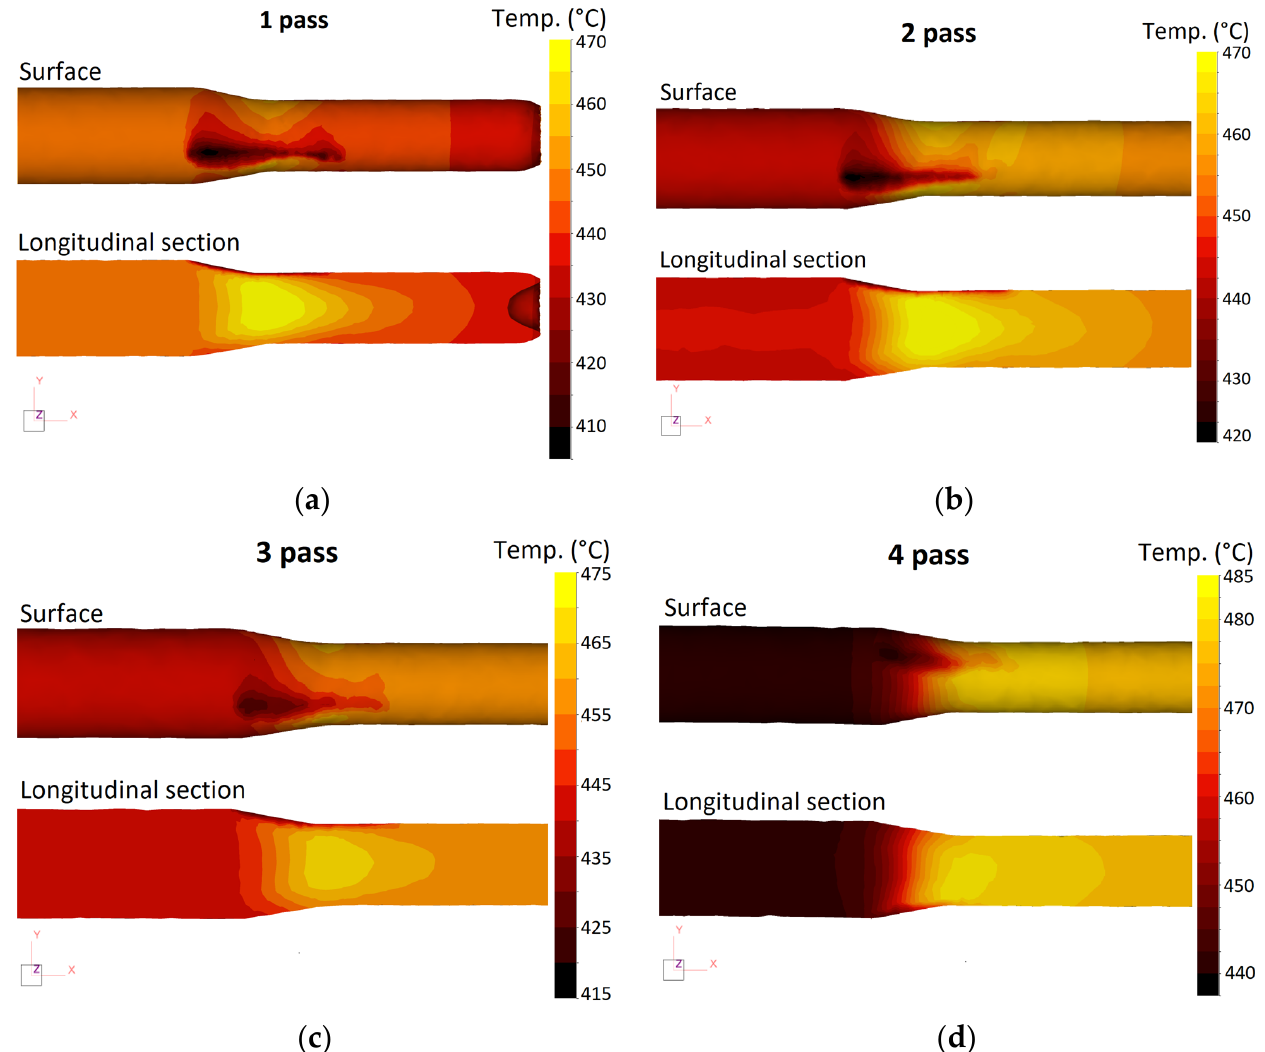
Figure 4. Distribution of the temperature field of the billet in the deformation zone in each pass: ( a ) first pass; ( b ) second pass; ( c ) third pass; ( d ) fourth pass.